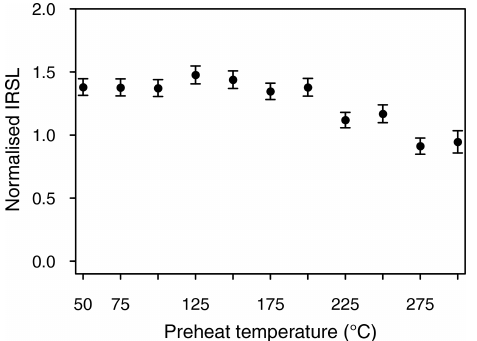
Figure 5. Short shine pulse annealing experiment on natural and laboratory-induced doses of two aliquots from RIN2 F. The IRSL signal is normalised to a test dose and renormalised to the first mea- surement.